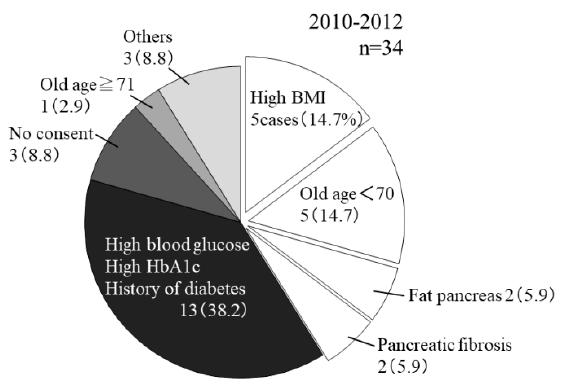
Figure 4. The analysis of the reasons for the non-utilization of pancreases from brain-dead donors (BDDs) for organ transplantation after the revision of relevant law. Pancreases from BDDs were not utilized for organ transplantation in 34 cases from 2010 to 2012. Depending on the situation, the possibility of diverting to islet transplantation was considered in cases in which the pancreas was not procured. The reasons for non-utilization of the pancreas in these cases included high body mass index (BMI), n = 5 (14.7%); age >70 years, n = 5 (14.7%); fatty pancreas, n = 2 (5.9%); and pancreatic fibrosis, n = 2 (5.9%).